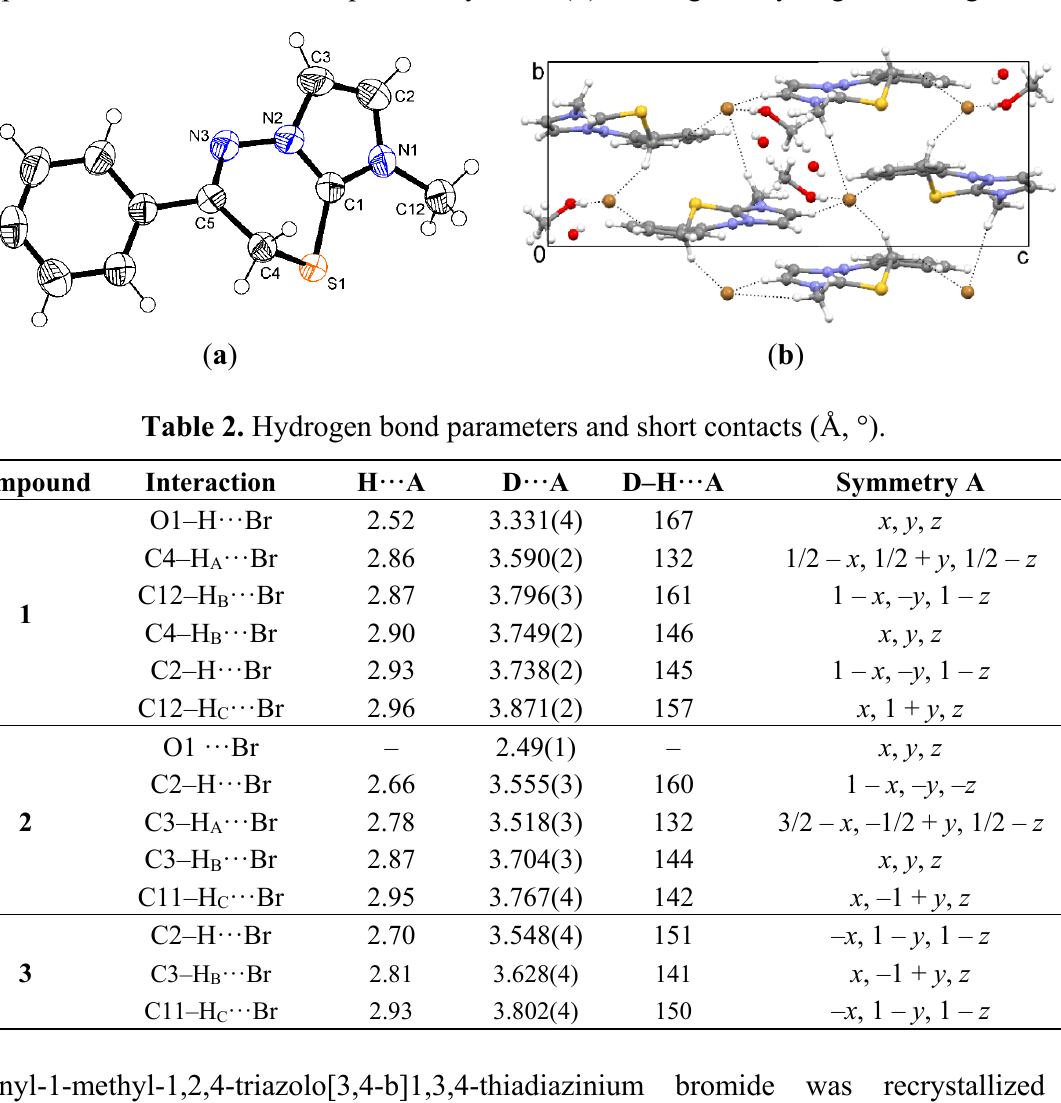
Figure 2. ( a ) O RTEP plot and atom numbering scheme of the cation; the displacement ellipsoids are drawn at the 50% probability level; ( b ) Packing and hydrogen bonding of 1 .